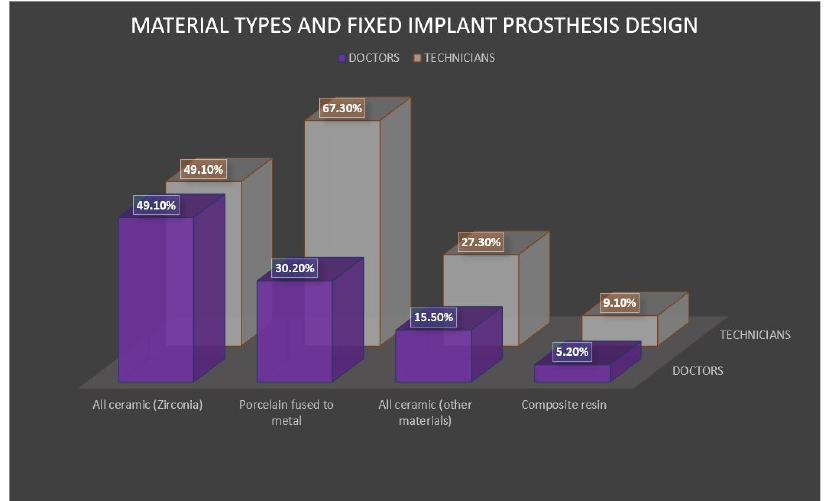
Figure 1. Type of materials used for anterior fixed implant restorations: doctors versus technicians.